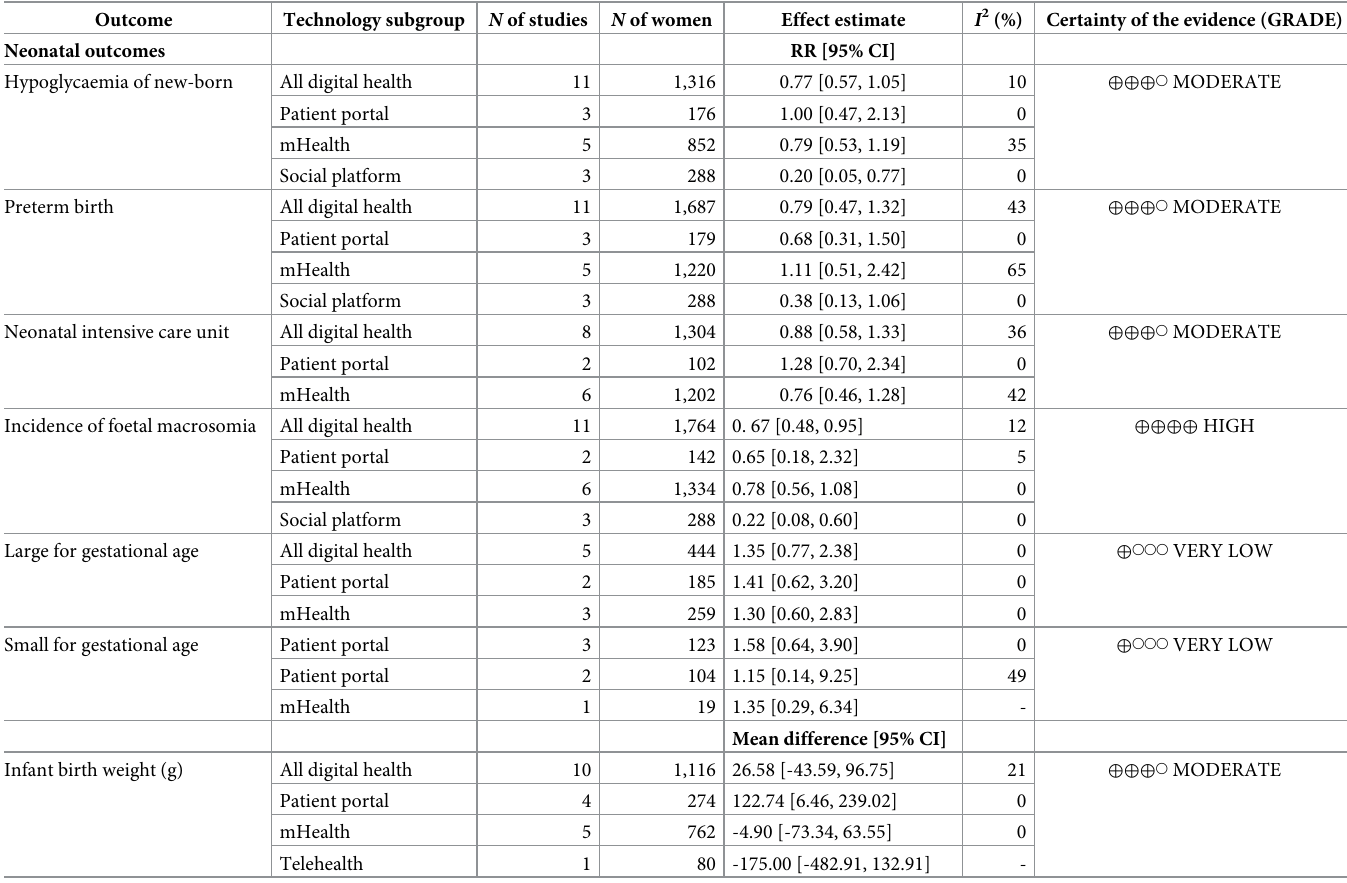
Table 4. Pooled analyses of neonatal